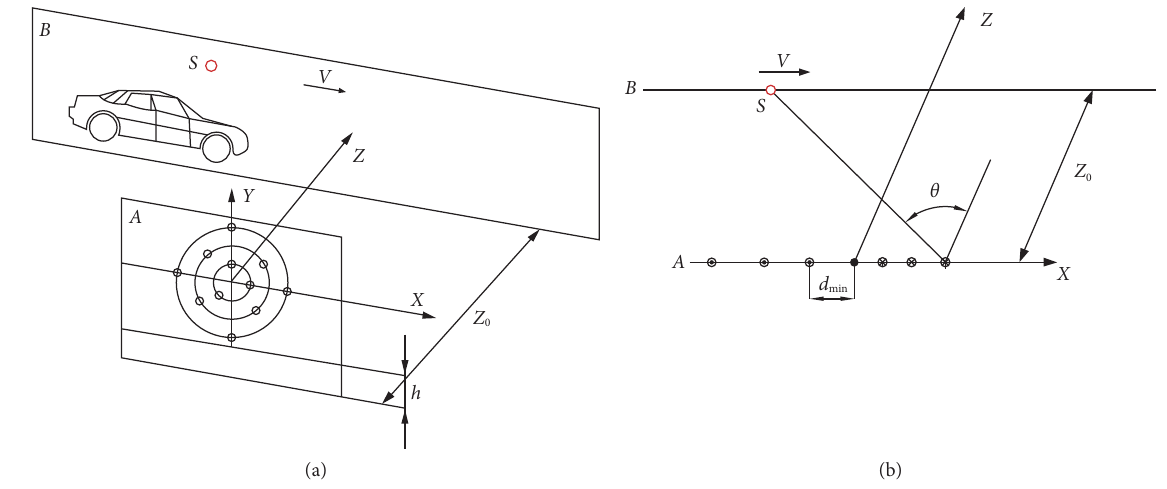
Figure 1: The relationship between the measurement array and reconstruction field: (a) isometric view; (b) top